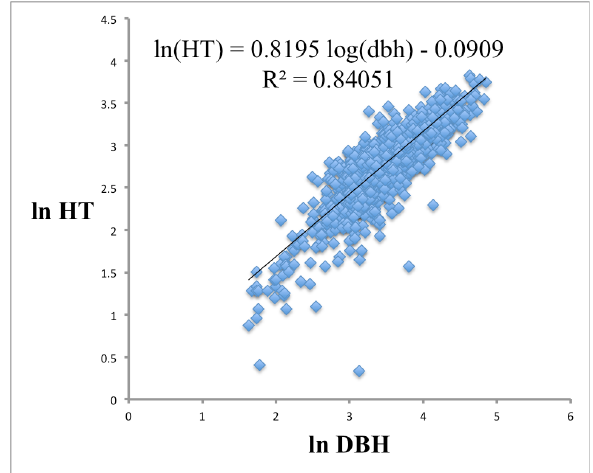
Figure 1.Constructed height – dbh allometric model at log- tranformed scale with field